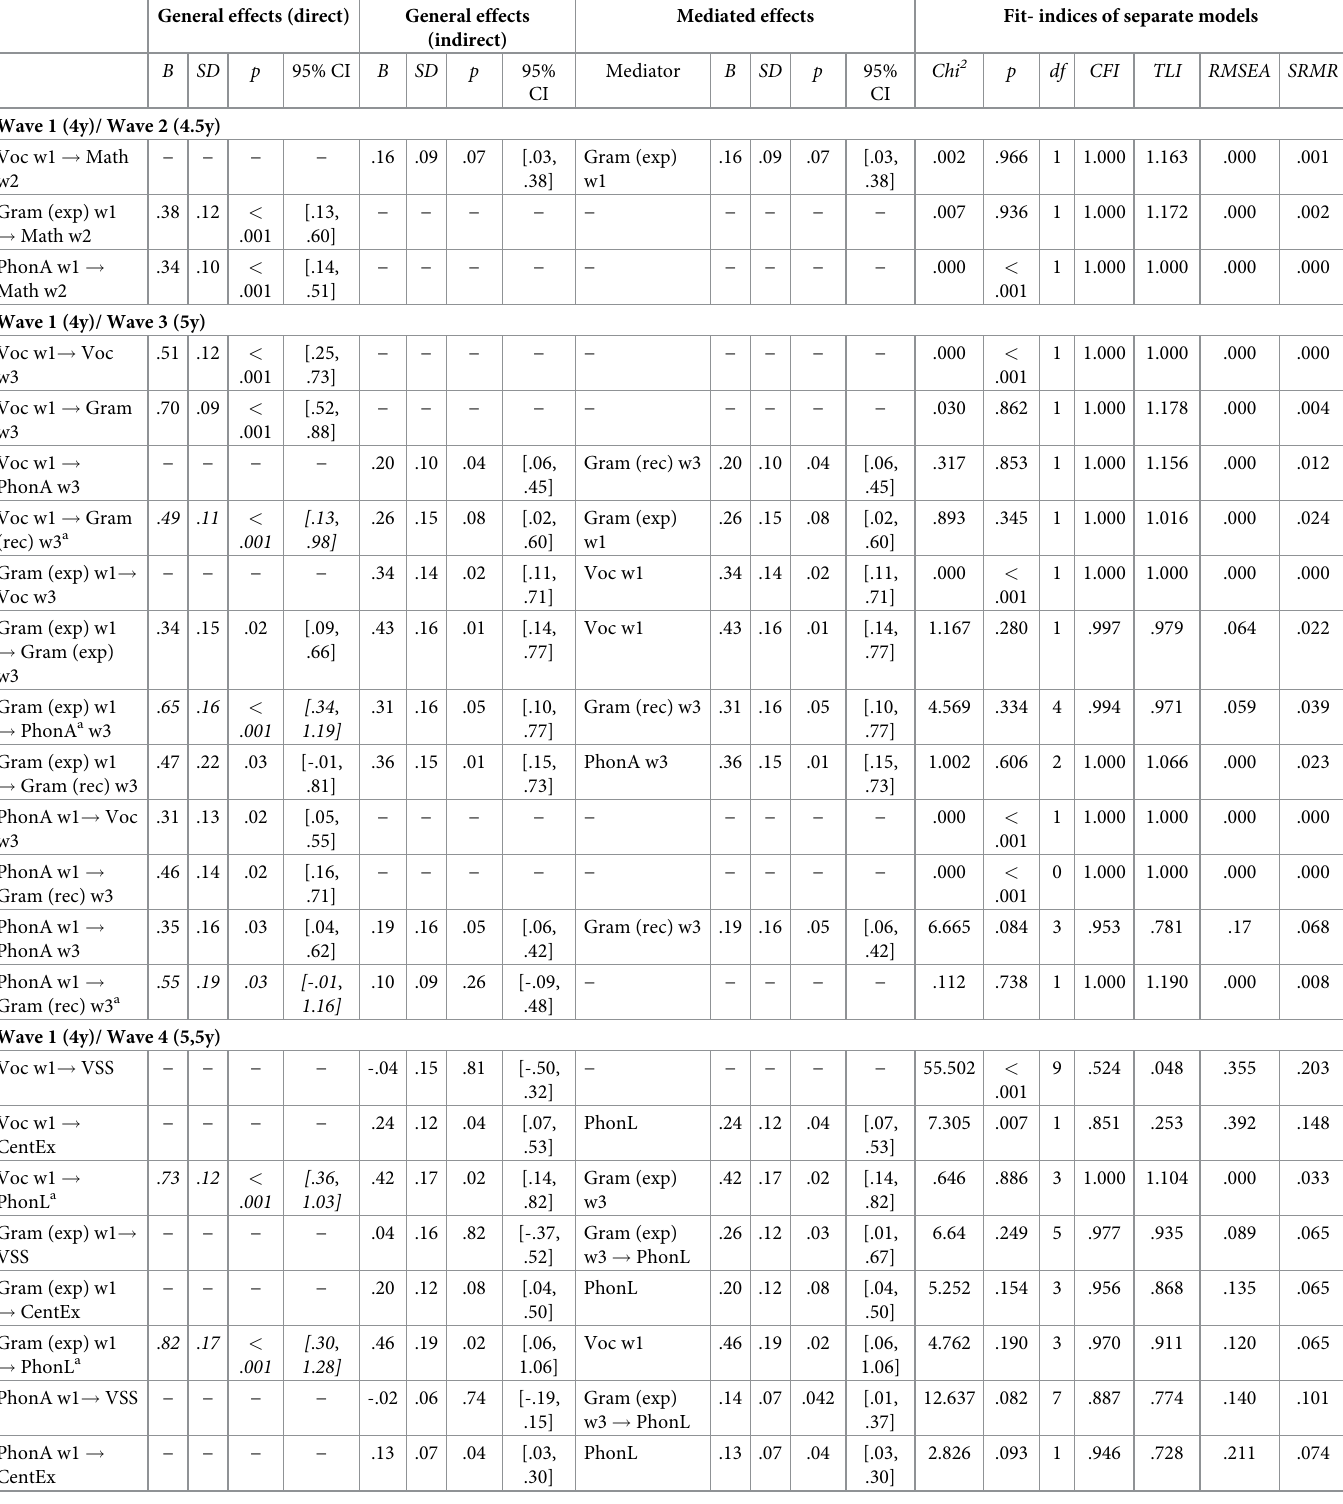
Table 3. Information regarding direct and indirect effects within the separate models of the general